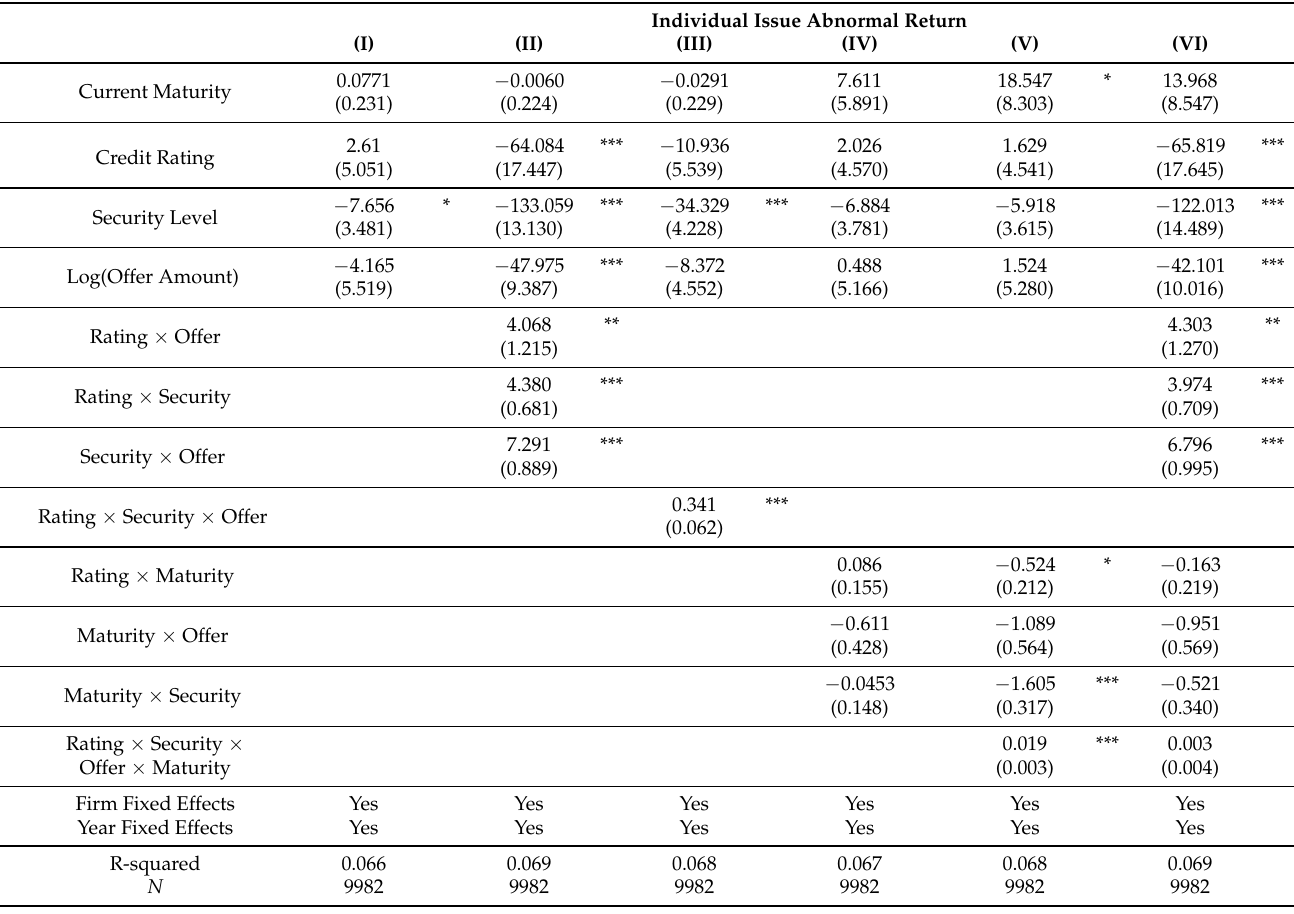
Table 9. Within Firm Multivariate